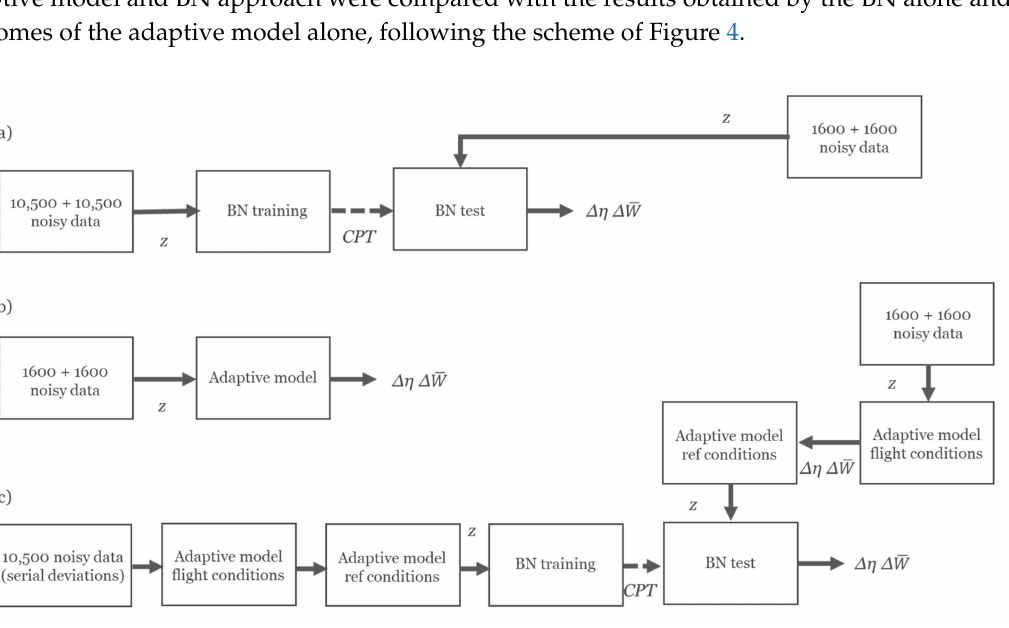
Figure 4. Schematic diagram of the three compared approaches: BN only ( a ), adaptive model only ( b ), and hybrid method with adaptive model and BN ( c